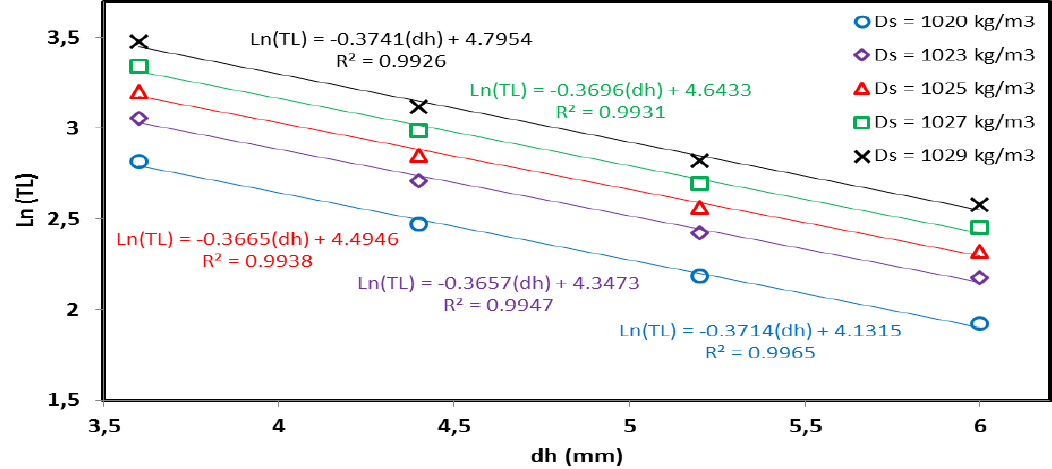
Figure 13. Change of the logarithmic toe length with the head difference for different saltwater density values.